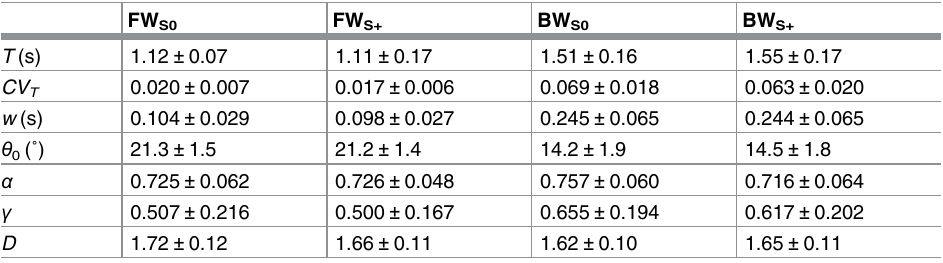
Table 1. Mean ± standard deviationsvaluesfor the parameters computed in the four experimental con- ditions. FW (BW) stands for forward (backward)walkingand S0 (S+) for no GVS (GVS